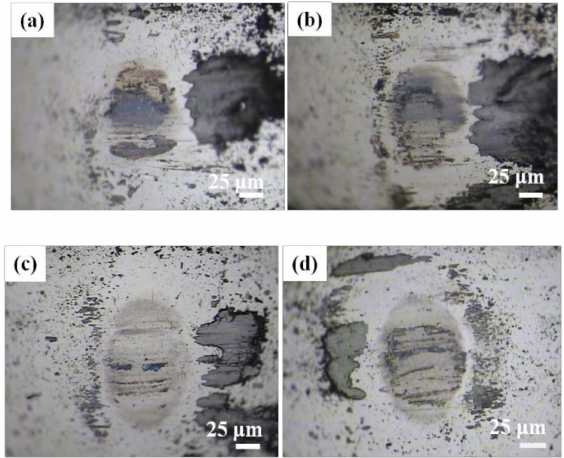
Figure 5. The friction coefficient curves of pure MoS 2 film, MoSN monolayer and MoSN/MoS 2 multilayer films in a high vacuum (1.3 × 10 − 3 Pa) environment. ( a ) The friction coefficient curves and ( b ) the film wear rates in the first 2.0 × 10 4 revolutions; the inset shows the two-dimentional profiles of the wear track.